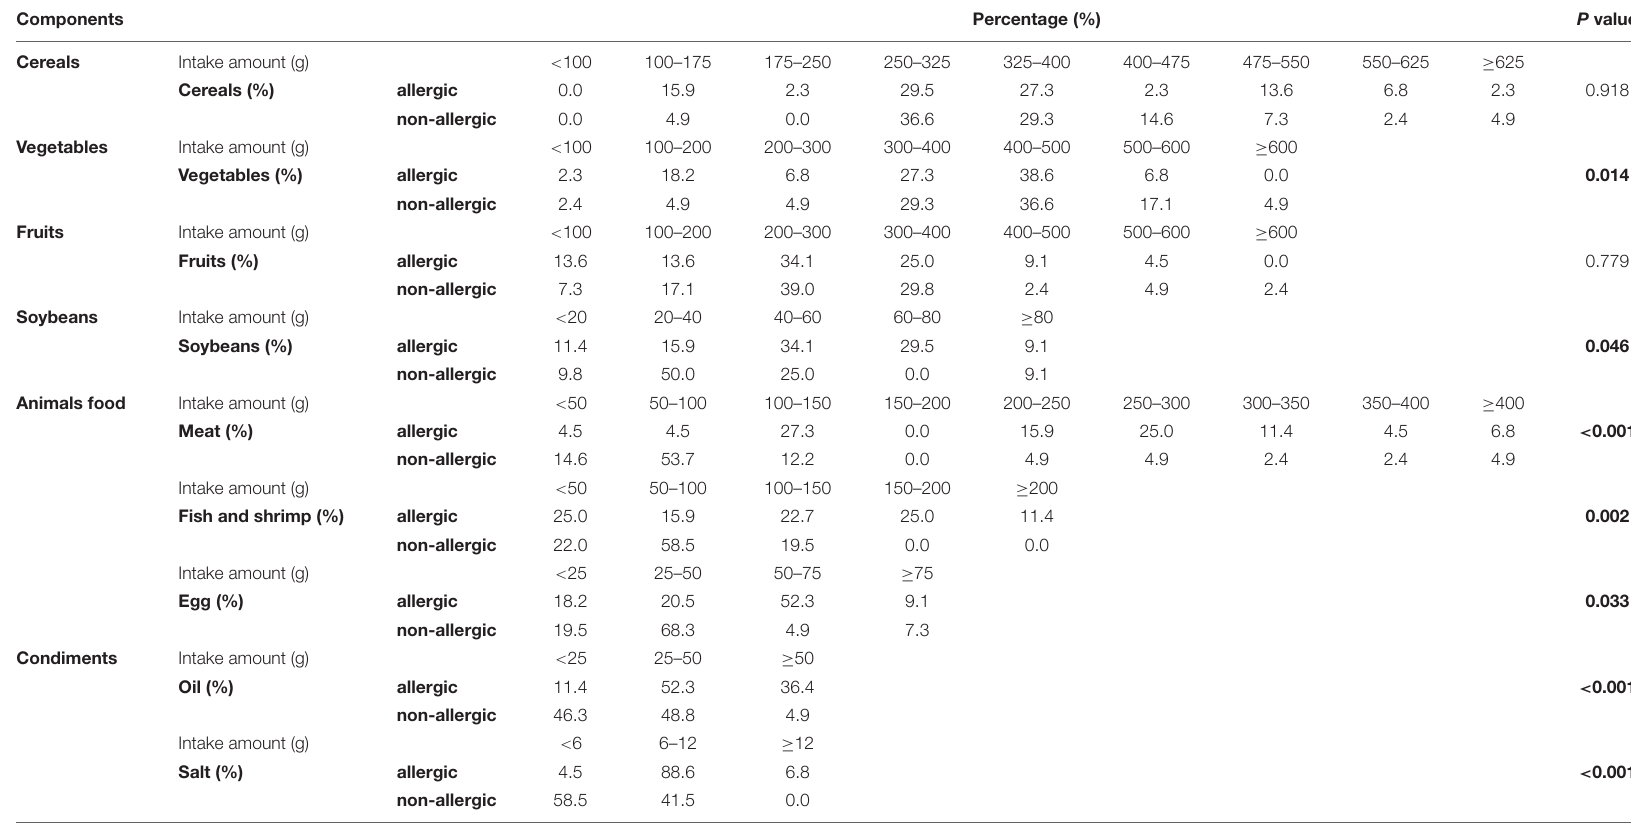
TABLE 2 | Components of food intake and its percentage in study participants.